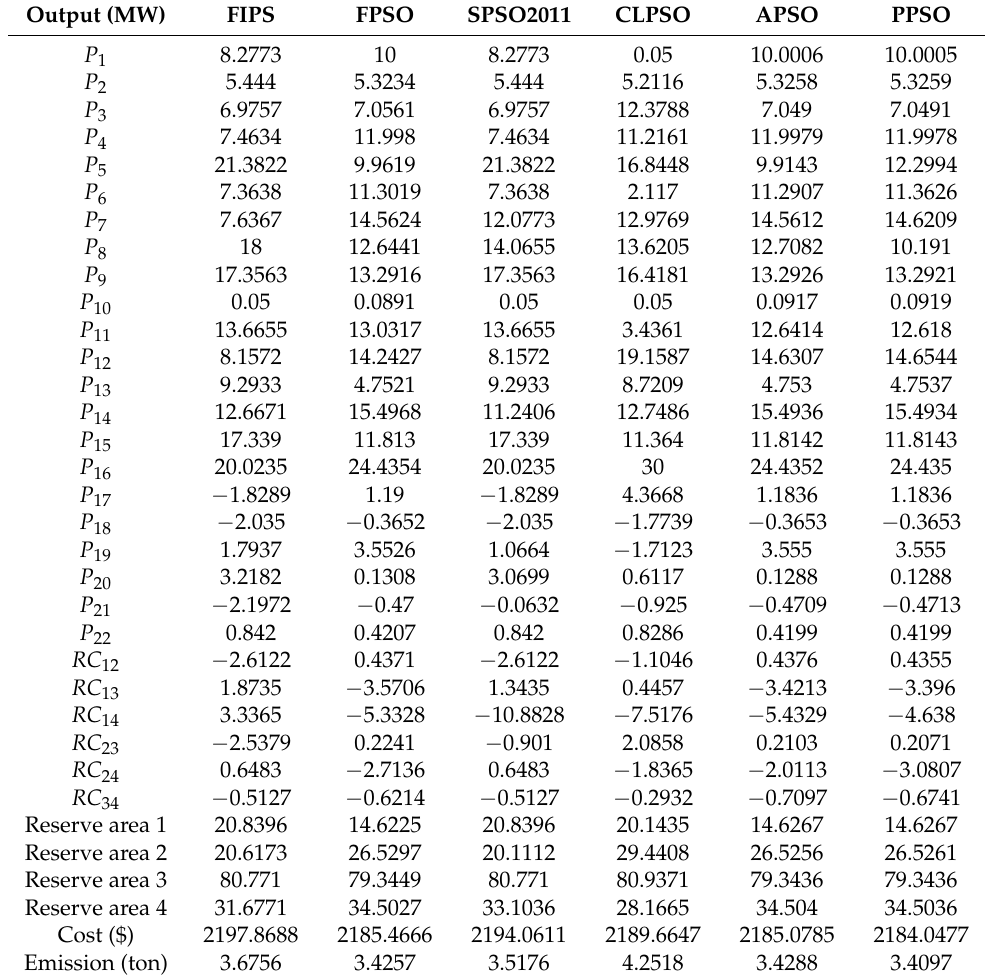
Table 6. Optimization results obtained by PSO optimizers for the RCMAEED problem for the four-area power